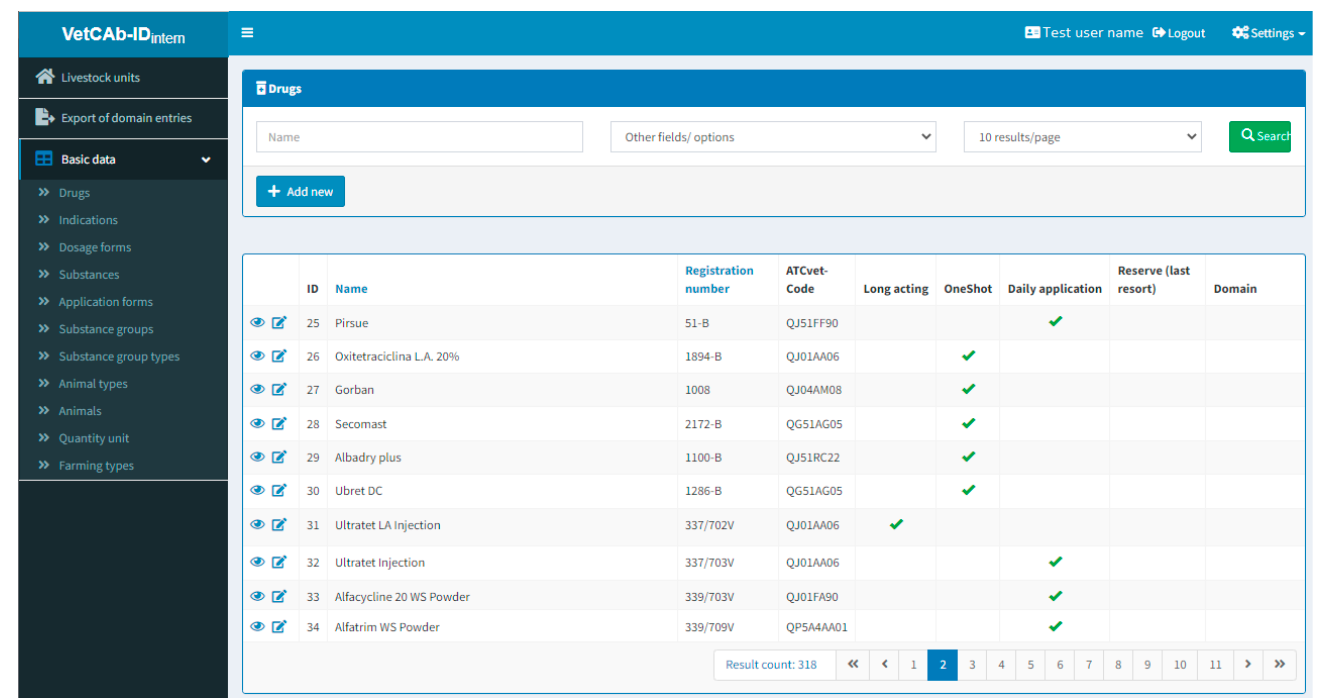
Figure 2. Screenshot from the second learning video for the VetCAb-ID database.